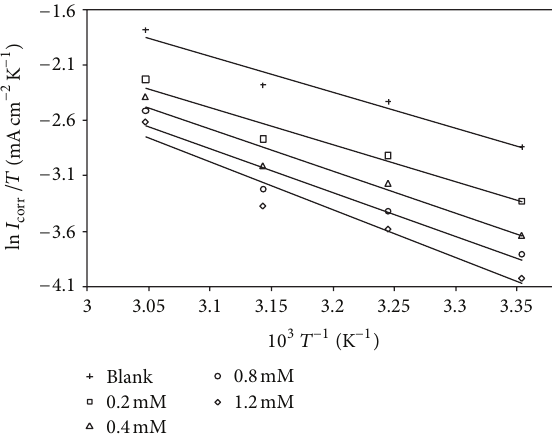
versus 1/𝑇 of 1M HCl and at corr